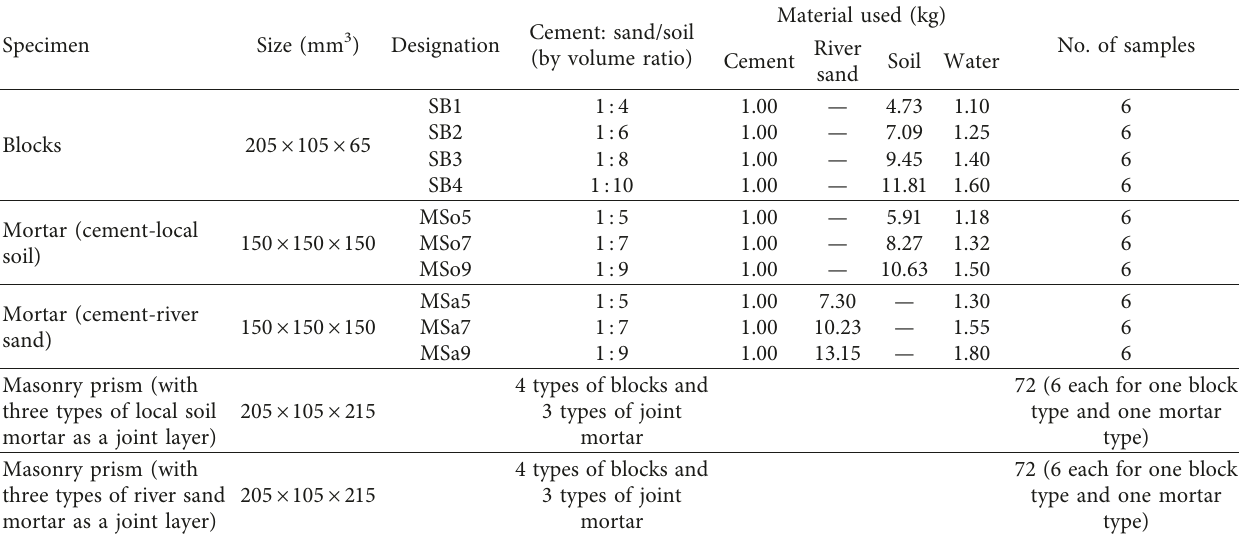
Table 3: Materials used in blocks, mortar, and